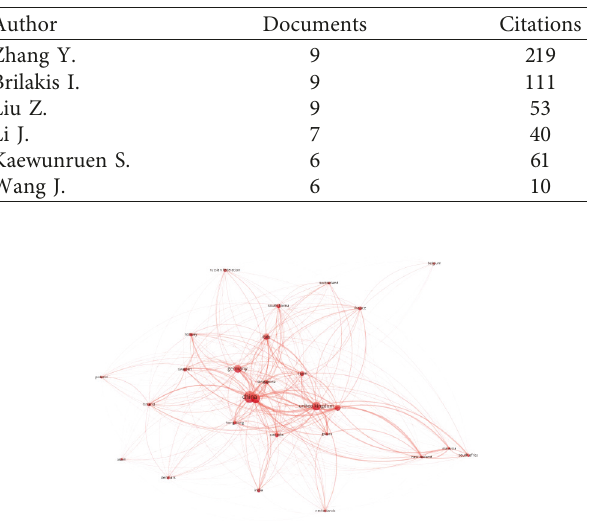
Table 4: List of the top 6 most productive authors (2017–2022).